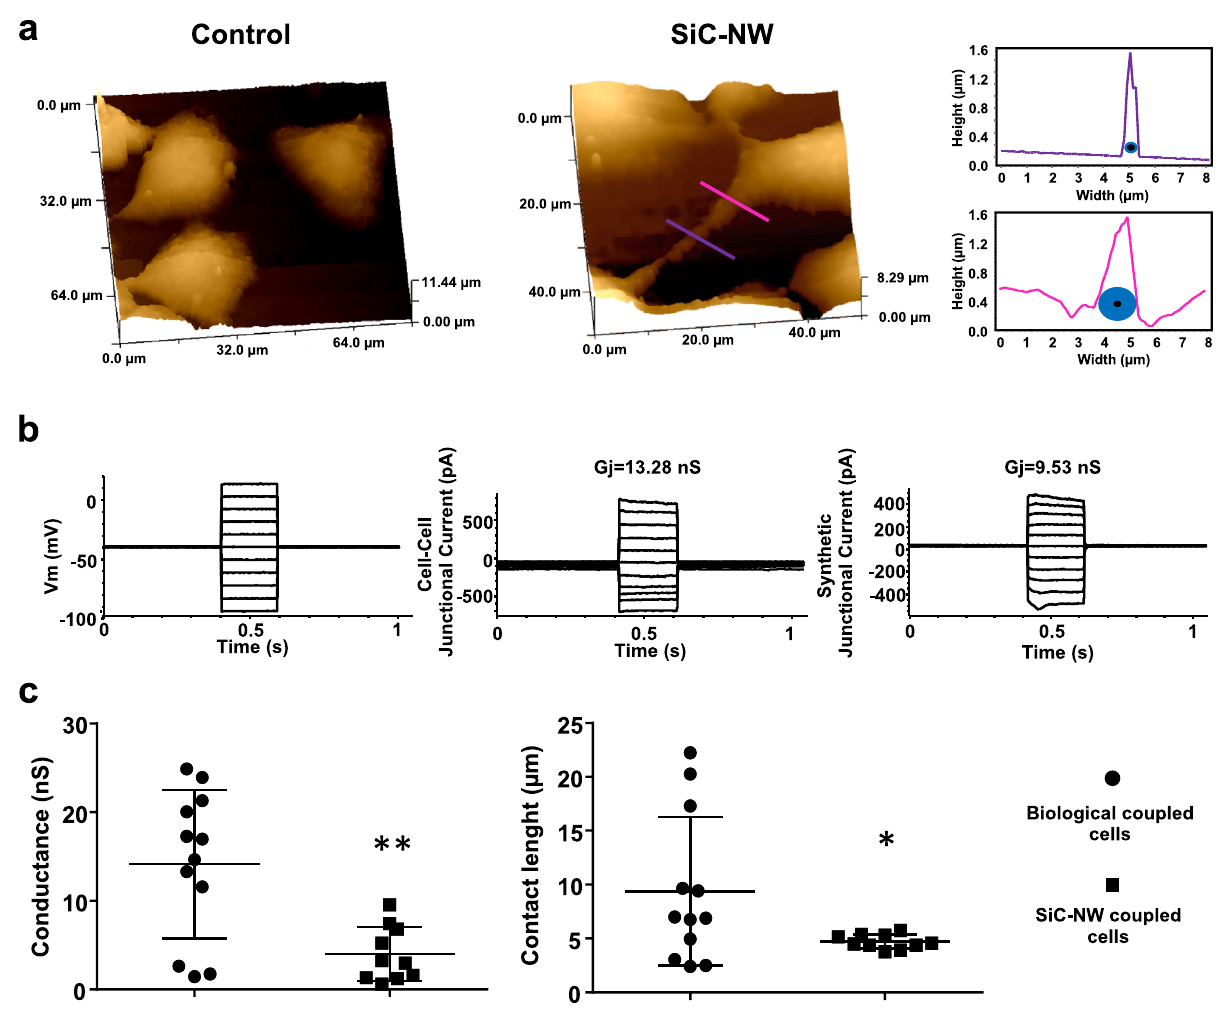
Fig. 2 Synthetic cell – cell communication via coupling with SiC-NWs. a Topographical imaging of HL1 cells with Hopping probe scanning ion conductance microscopy (HPICM): biological cell – cell coupling (Control, left); synthetic cell – cell MNB-based coupling obtained with SiC-NWs (SiC-NW, middle); quanti fi cation at the purple and pink lines of the middle image (right) ( n = 5 experiments repeated with similar results). b Representative dual patch-clamp traces from biologically and synthetically coupled HL1 cell pairs. Voltage gradient applied to the cell source (left); and junctional conductance in biologically connected (middle) and SiC-NW-connected (right) cell pairs ( n = 5 experiments repeated with similar results). c Cell – cell conductance (left) and contact length (right) for biologically coupled and synthetic SiC-NW-coupled HL1 cell pairs. n = 12 for biological coupled cells, black circles; n = 10 for SiC-NW coupled cells, black squares. Data are represented as mean ± SD. Unpaired two-sided Student ’ s t -test. * p = 0.046 vs. biological coupled cells; ** p = 0.0017 vs. biological coupled cells. Source data are provided as a Source Data fi